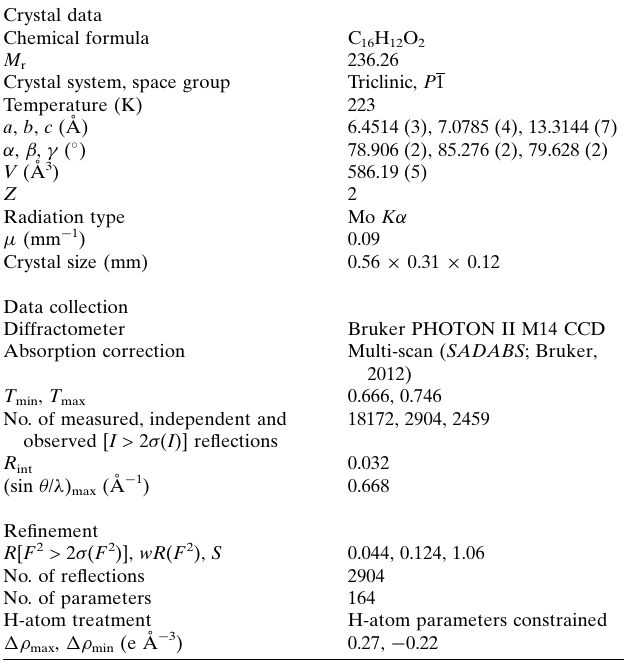
Table 2 Experimental details.